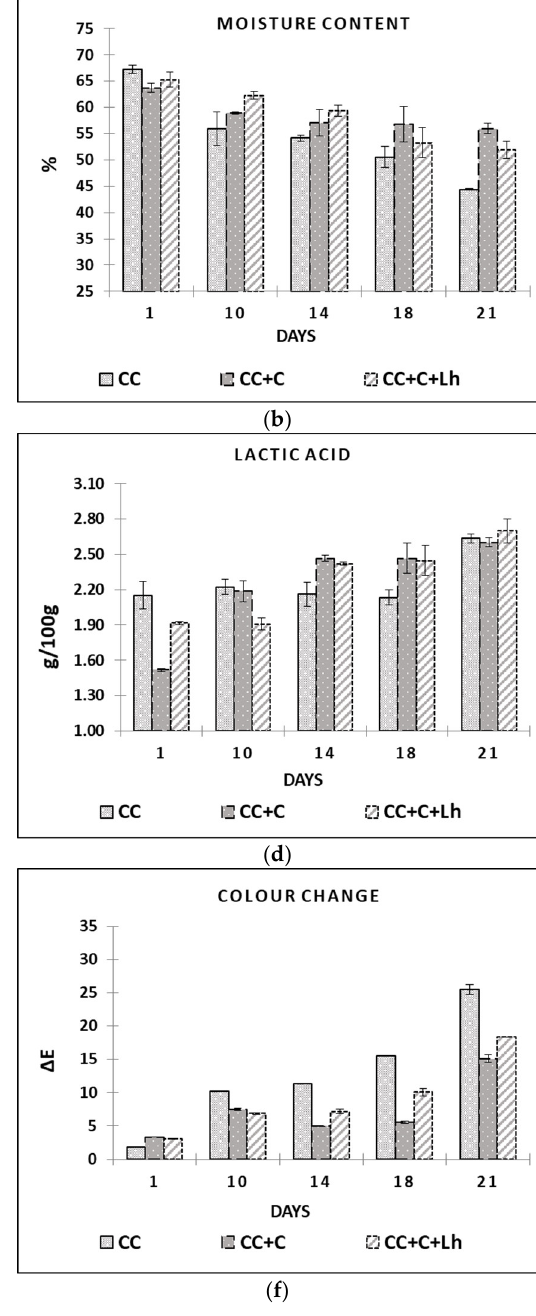
Figure 2. Weight loss ( a ), moisture content ( b ), pH ( c ), lactic acid content ( d ), texture ( e ), and colour change ( f ) in control acid-curd cheese (CC), coated acid-curd cheese (CC + C), coated acid-curd cheese with L. helveticus (CC + C + Lh) during 23 days of storage at 4–6 °C (mean values ± SD). The storage day, sample factors, and their interaction had a significant impact ( p ≤ 0.0001) on instrumentally measured acidity, texture, and colour parameters (Figure 2a–f).